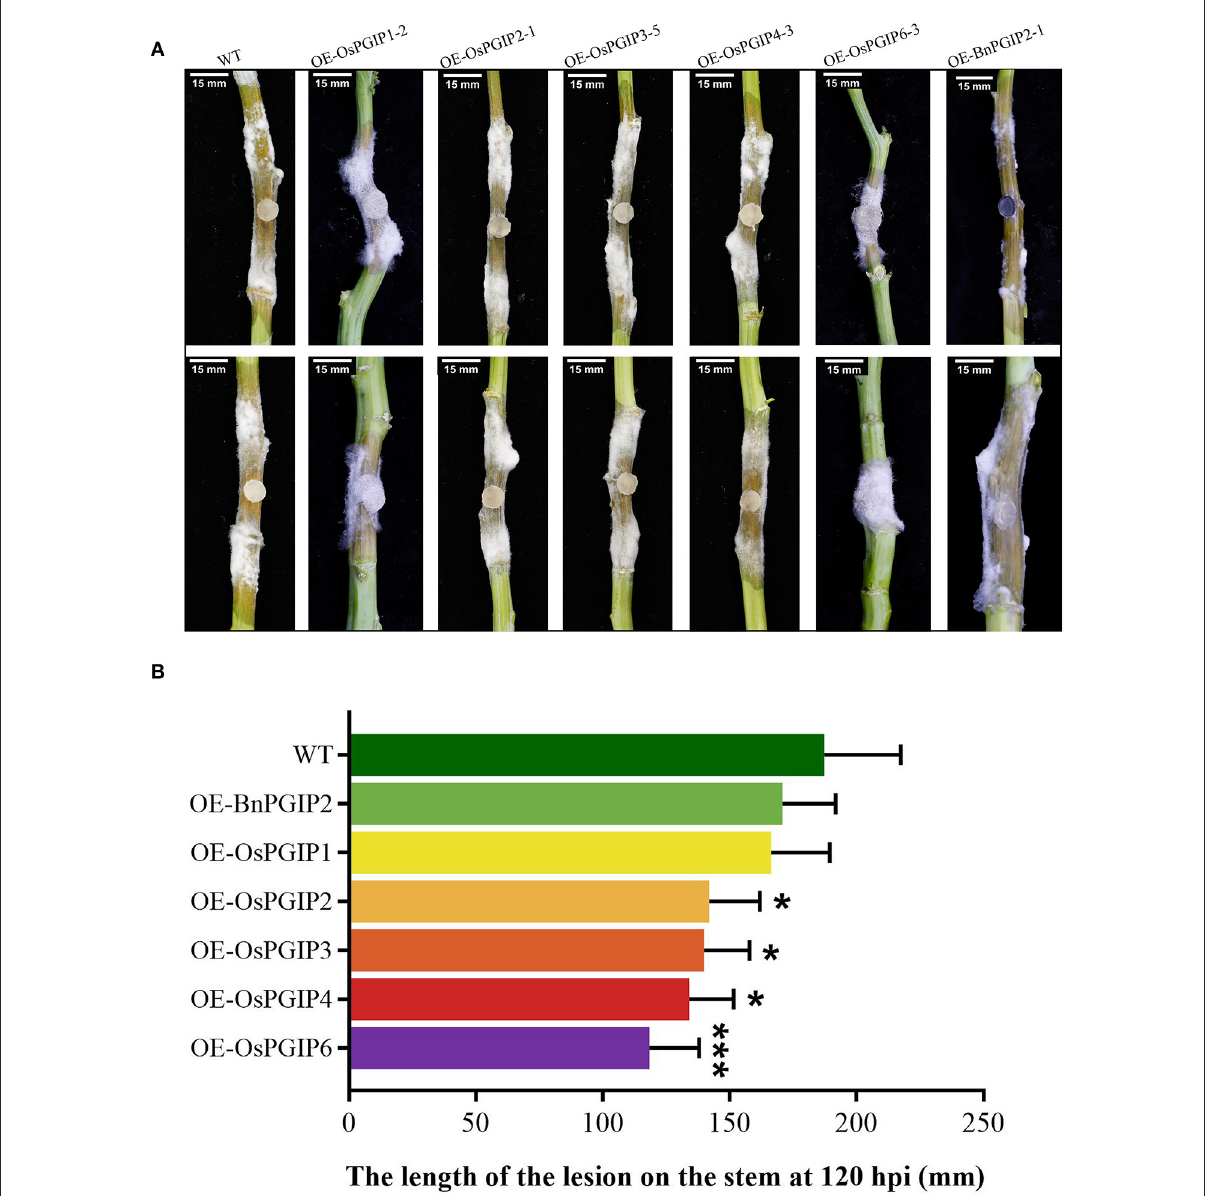
FIGURE7 OsPGIPx overexpression conferred resistance to S. sclerotiorum in detached stem inoculation. (A) Stems of transgenic lines and non-transgenic line 120h after inoculation with S. sclerotiorum . Scale bars are 15mm. (B) Lesion on stem at 120 hpi. Significant differences were showed by: *** P < 0.001, * P < 0.05. Error bars indicate SE based on five independent biological